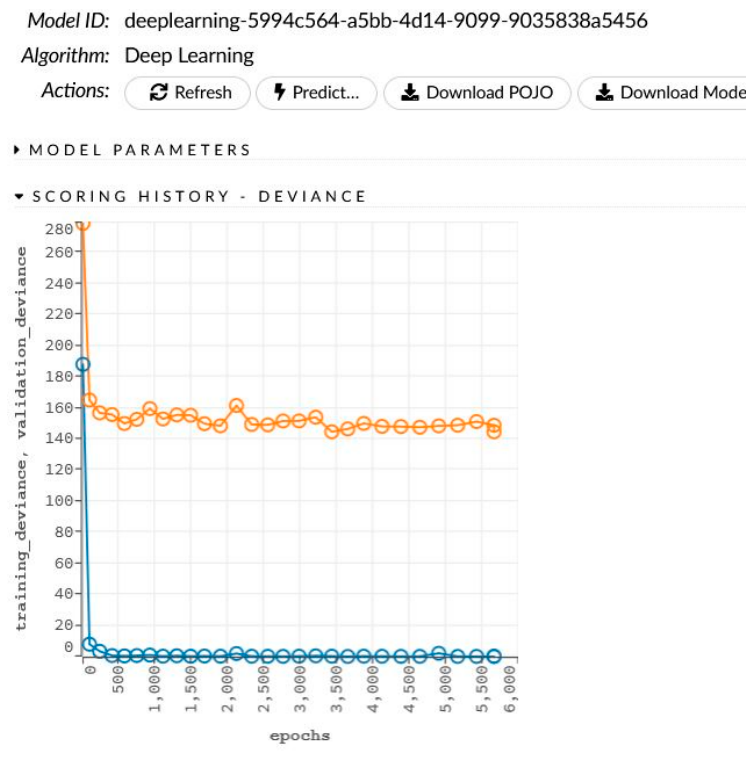
Figure 6. The generated model for women and the learning process. Table 6. Parameters of the generated model—age assessment for men.